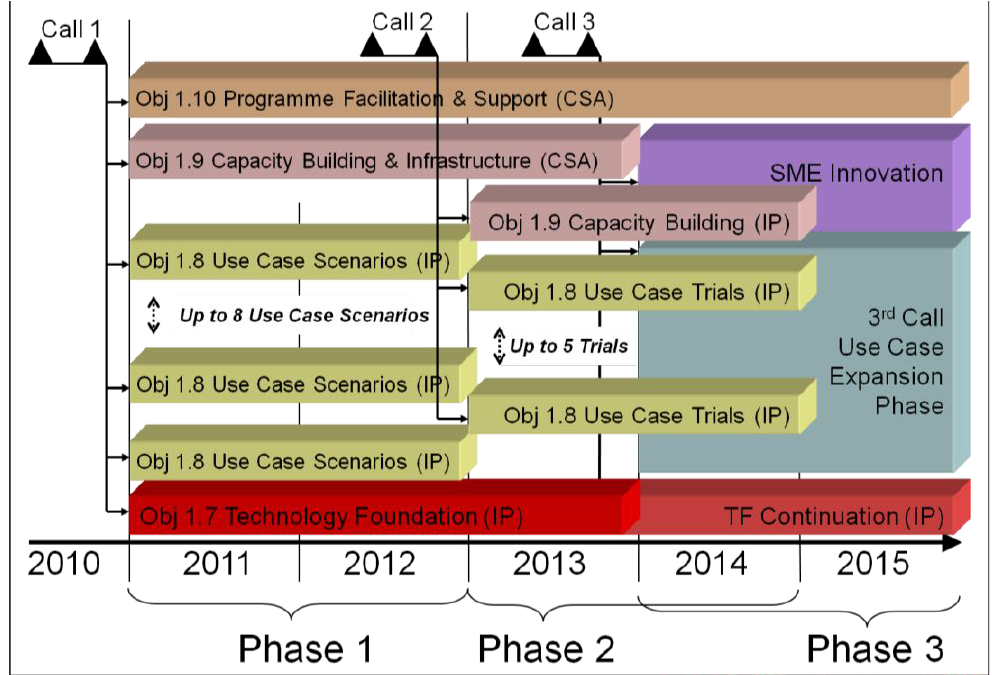
Figure 3. Timeline of the future internet public-private partnership programme (from Europe’s Information Society Thematic